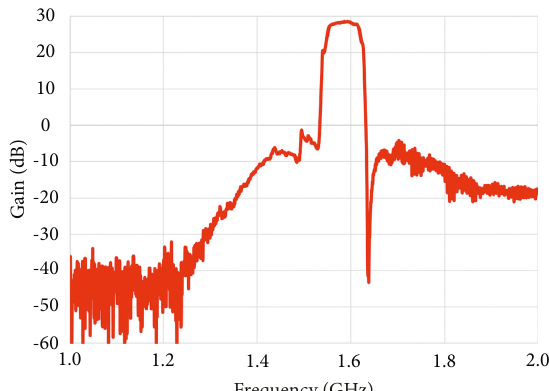
Figure 20: Final LNA gain.